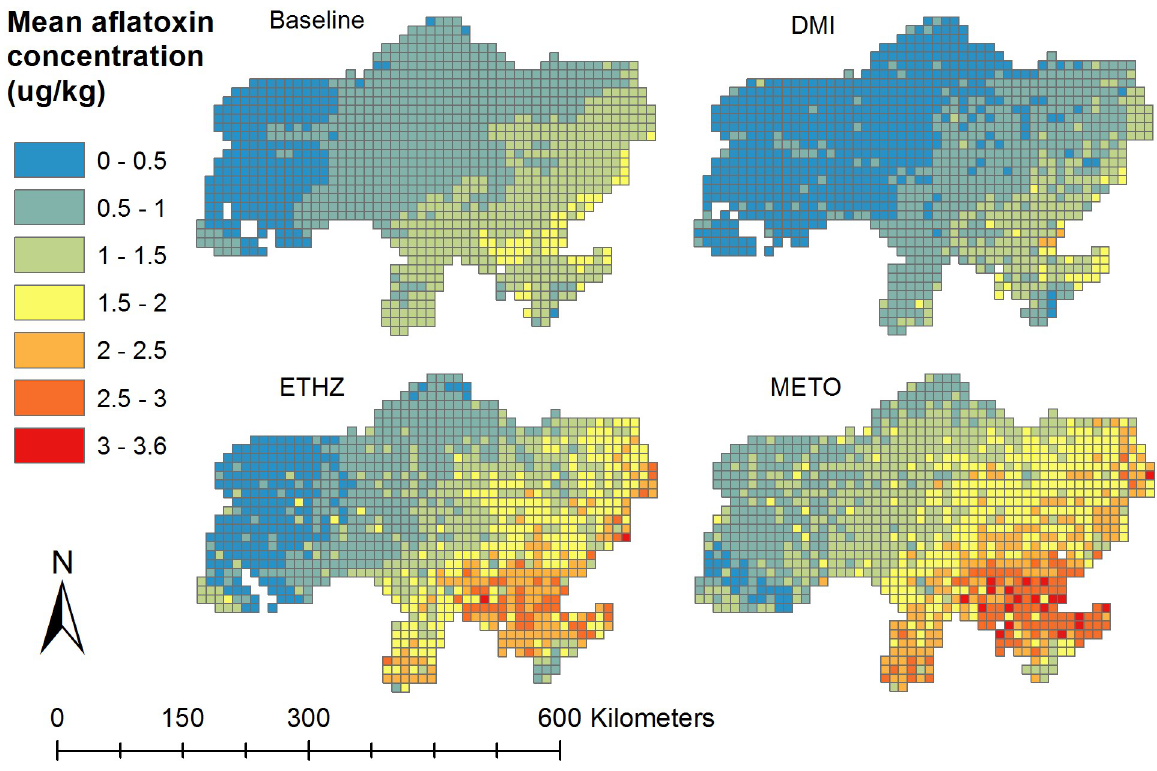
Fig 2. Maps of predicted mean aflatoxin (AfB1) concentration ( μ g/kg) in maize grown in Ukraine, for baseline conditions and for 2030 using three different climate models (DMI, ETHZ, and METO).